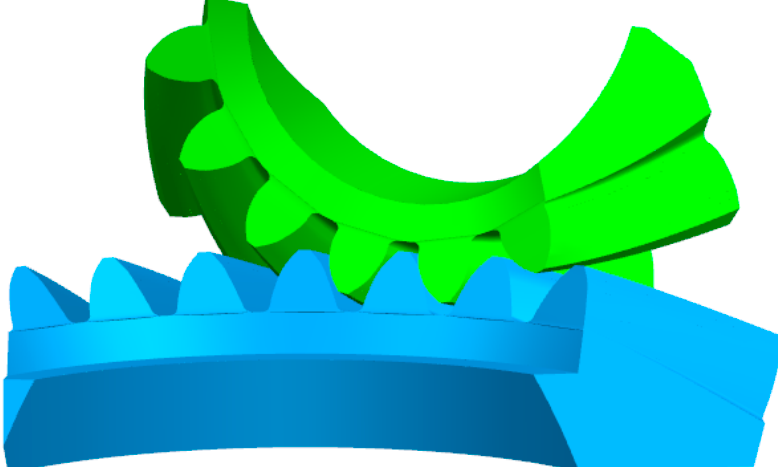
Figure 1. Spiral bevel gear assembly model.